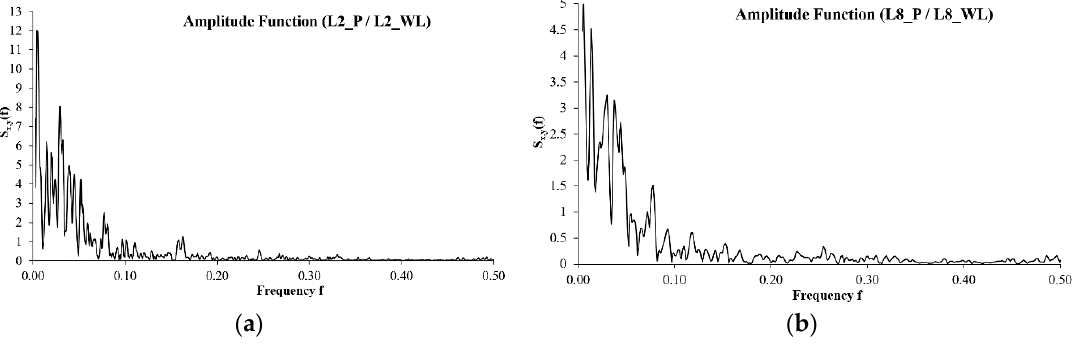
Figure 18. ( a ) Amplitude function between L2_P and L2_WL data; ( b ) amplitude function between L8_P and L8_WL data.